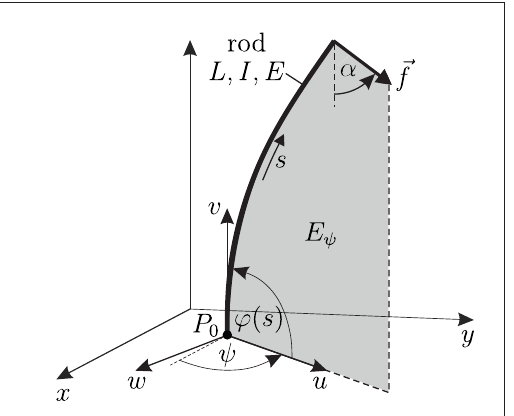
Figure 4. Mechanical model of the isolated artificial vibrissa in the inference of some contact